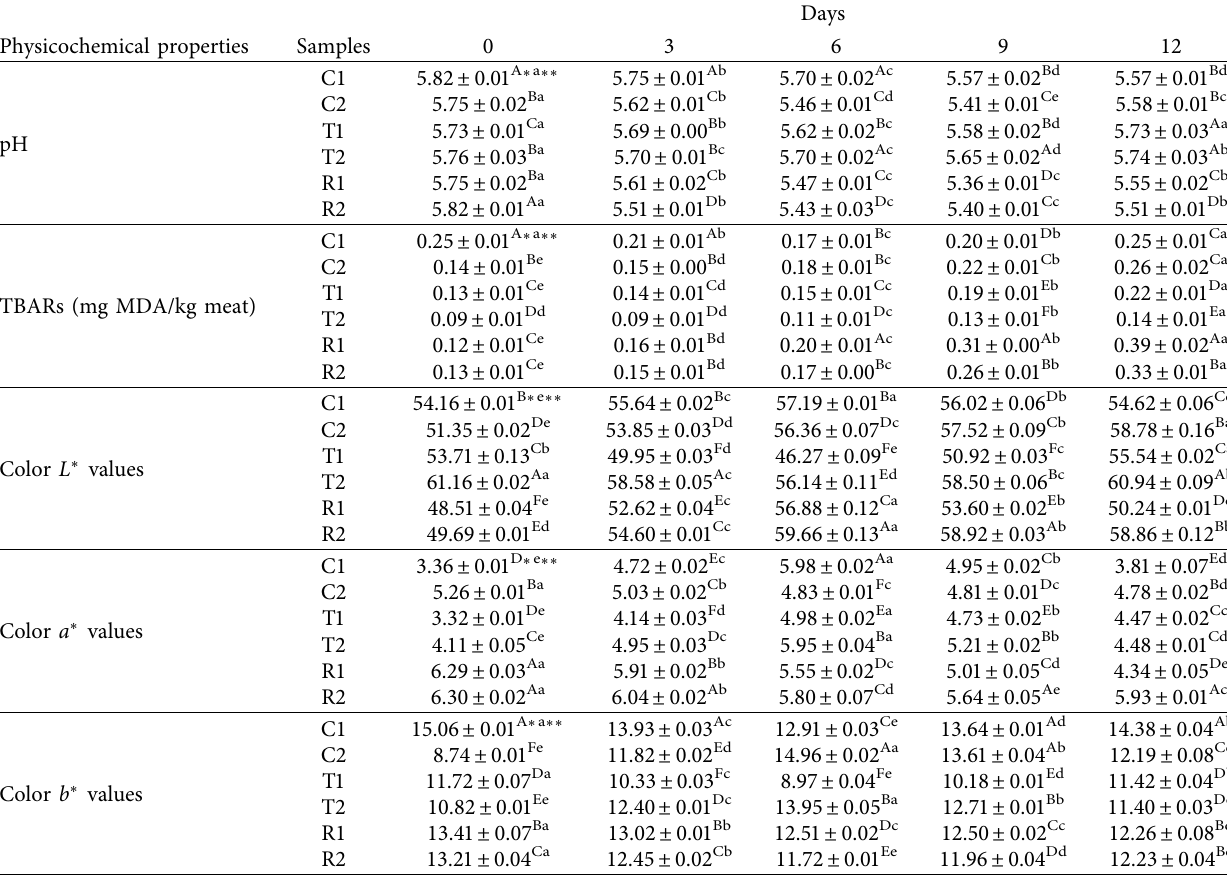
Table 3: Efect of thyme and rosemary EOs on physicochemical properties of vacuum-packaged chicken breast samples during refrigeration (mean ±